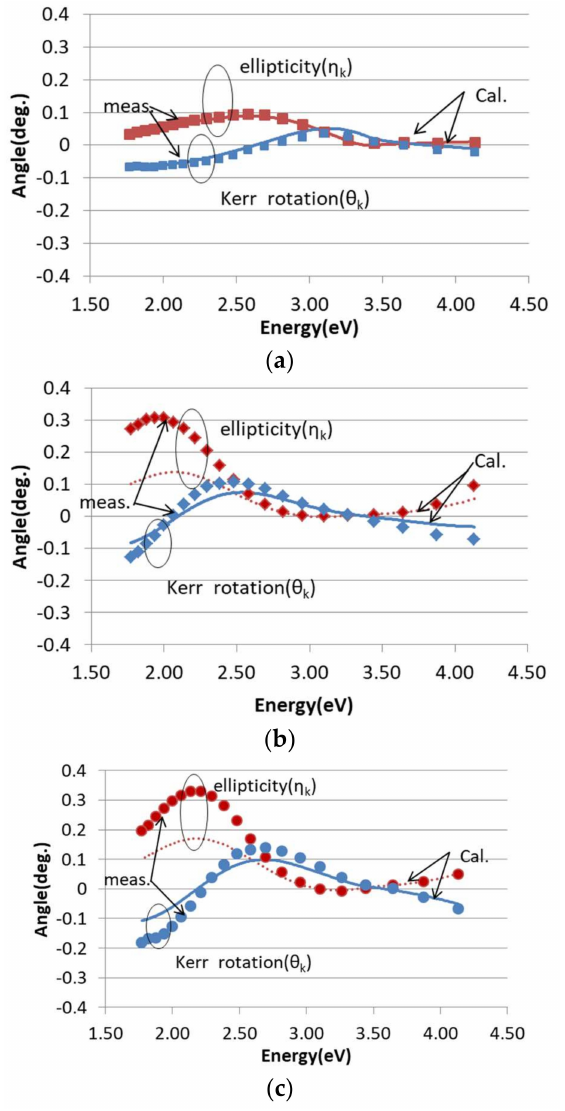
Figure 6. Simulated magneto-optical Kerr spectra of the samples (lines) and measured ones (dots) as a function of photon energy ( a ) Pt (3 nm)/TbCo (6 nm) /Pt(3 nm), ( b ) Si 3 N 4 (10 nm)/TbCo (6 nm)/Pt (3 nm) and ( c ) Pt (3 nm)/TbCo (6 nm)/Si 3 N 4 (10 nm) Blue dots and lines show Kerr rotation θ K and red dots and lines show ellipticity η K